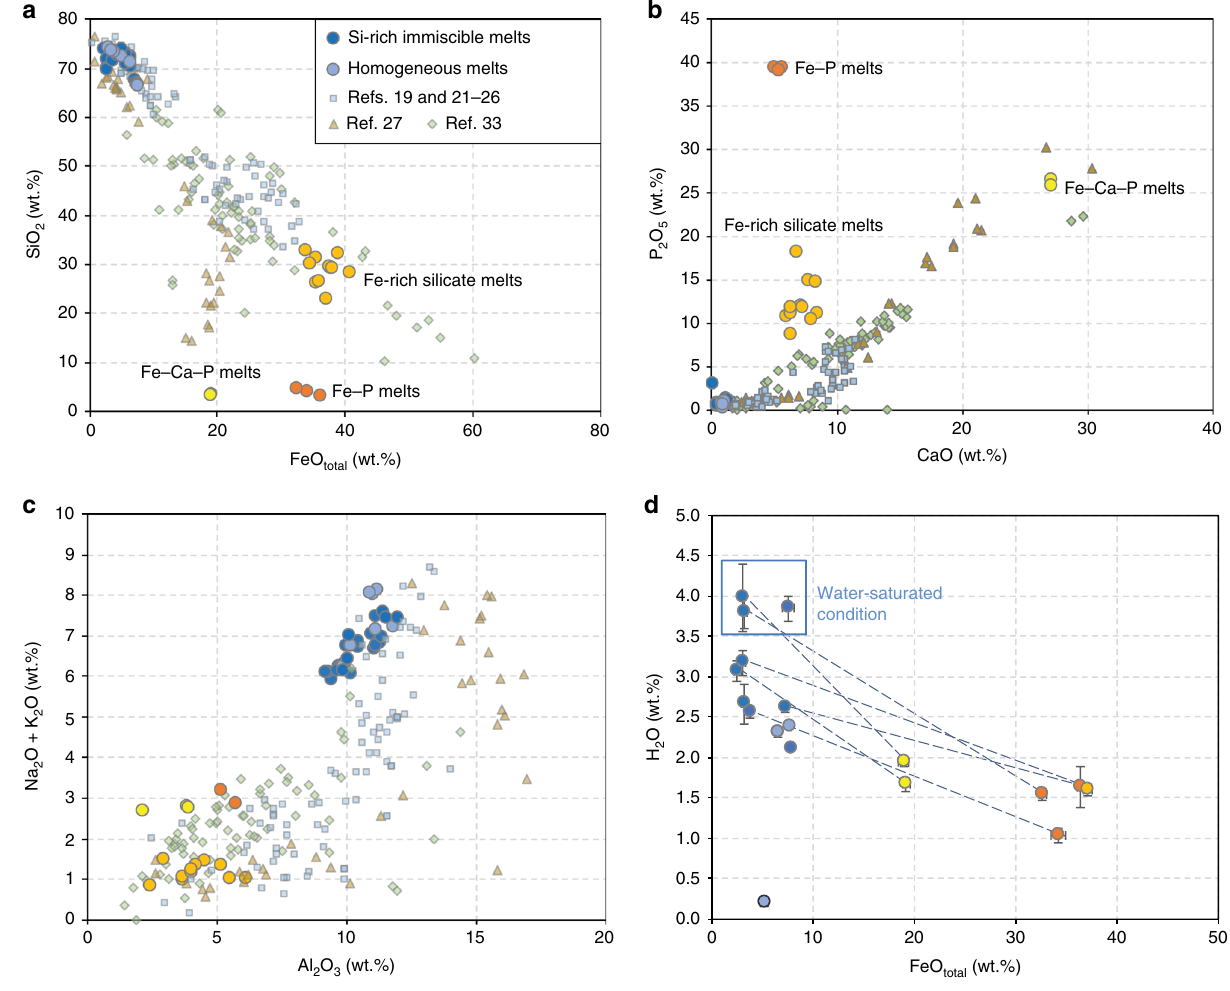
Fig. 2 Compositional variations of the experimental melts: a FeO tot vs. SiO 2 ; b CaO vs. P 2 O 5 ; c Al 2 O 3 vs. Na 2 O + K 2 O; and d H 2 O vs. FeO tot . Three types of Fe-rich immiscible melts were produced: Fe-rich silicate melts and Fe – P and Fe – Ca – P melts. Literature data are plotted for comparison: Fe-rich melts in the mesostasis of natural samples 33 , mineral-hosted melt inclusions 27 , and experimental immiscible melts in tholeiitic systems 19, 21 – 26 . Error bars represent one standard deviation of replicate